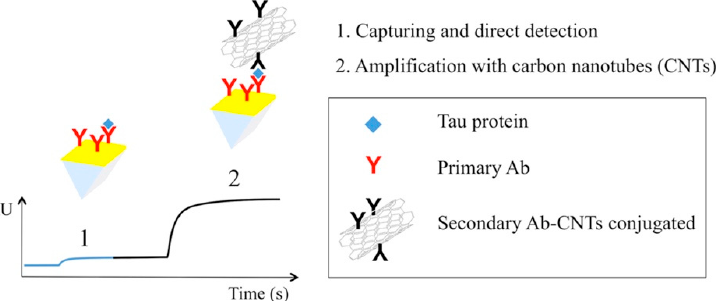
Figure 8. Effect of CNTs during plasmonic biosensing. Reprinted with permission from Biosensors and Bioelectronics, Copyright 2017, Elsevier [52]. Table 1. Carbon nanotube-based cancer detection techniques.